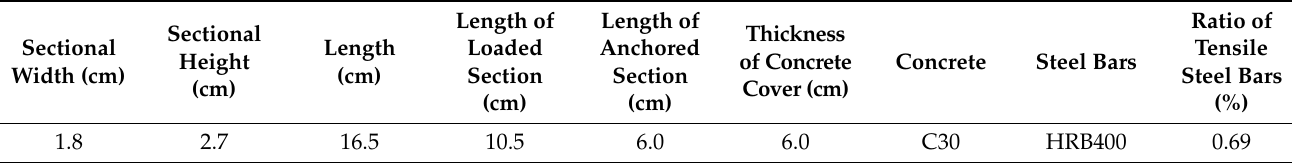
Table 3. Parameters of the dimensions and reinforcement of the test pile.